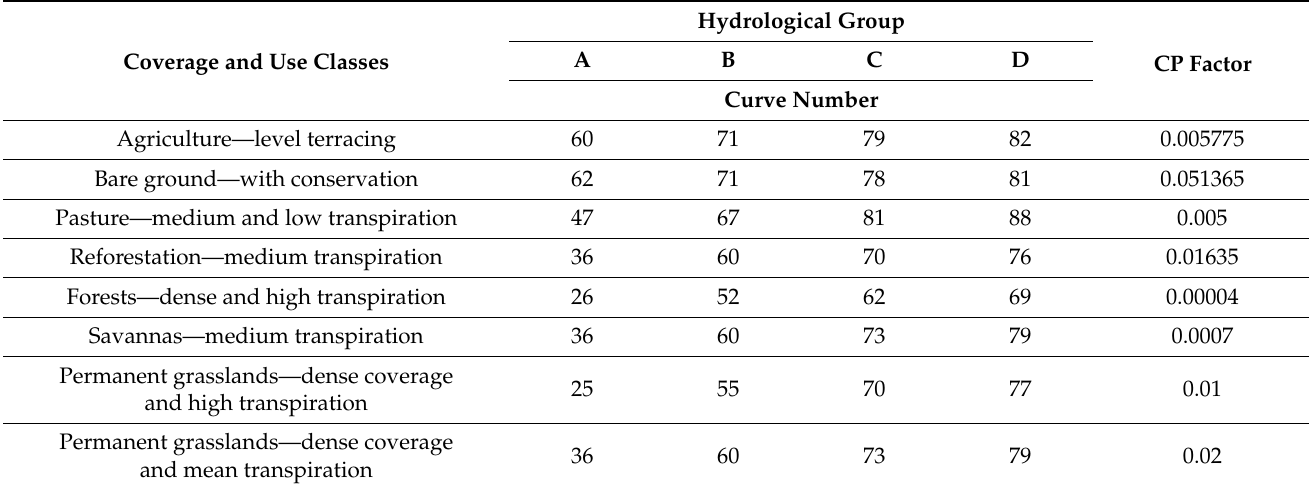
Table 2. Land cover and land use types and conditions, Hydrologic Groups, Runoff Number (considering accumulated rainfall greater than 53 mm in the last five days), and CP factor. Source: Prepared by the authors from the multi-spectral Instrument (MSI) sensor of the Sentinel-2 satellite, with passage on 8 June 2020 and adapted from